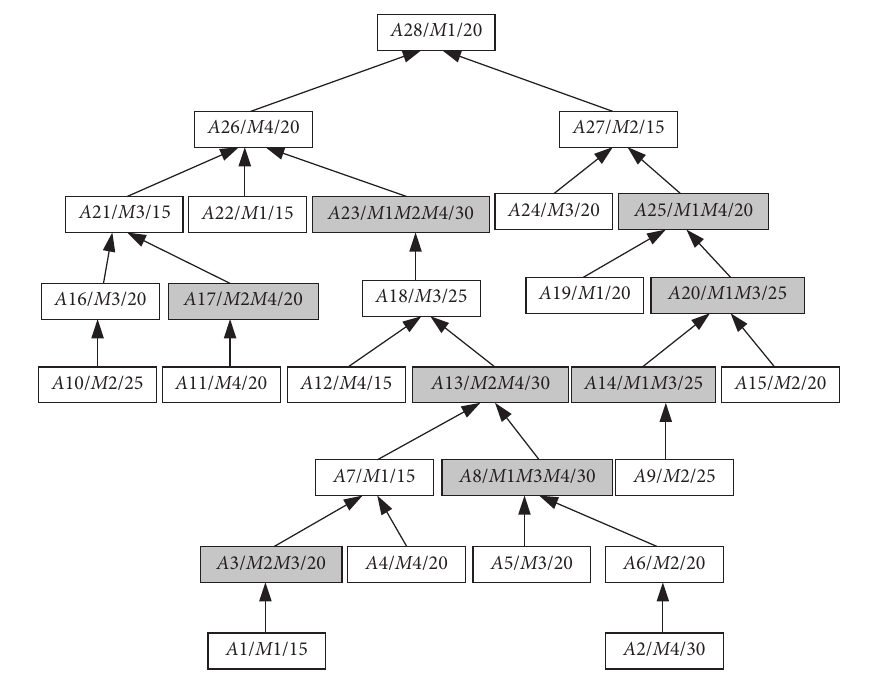
Figure 5: Product processing tree.